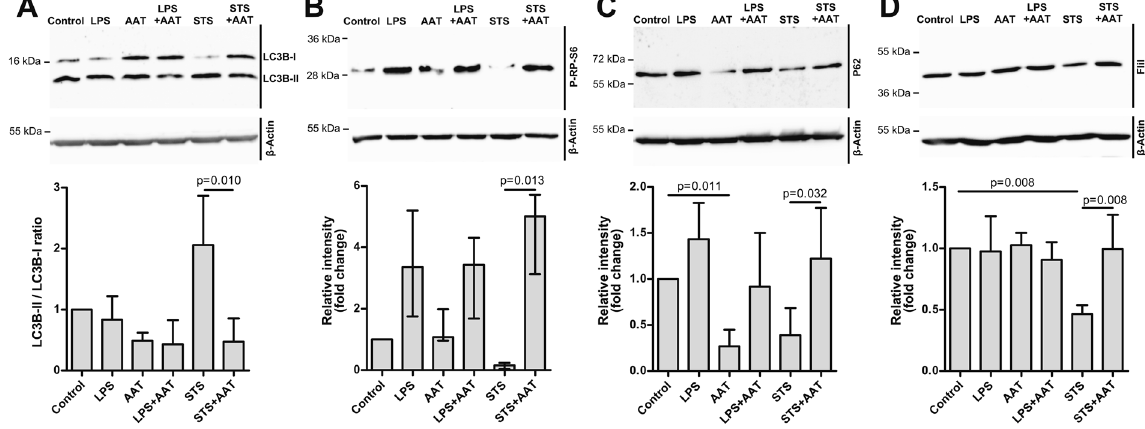
Figure 7. Exogenously added AAT prevents STS-induced inhibition of autophagy. H1975 cells were cultured in medium alone (controls) or in medium containing 50 nM STS, 10 µ g/ml LPS, or 1.5 mg/ml AAT separately and in combination for 2 or 18 h. Cell lysates were analysed by Western blot. ( A ) for LC3B analysis, cell lysates were prepared after 2 h incubation time. LC3B-II versus LC3B-I ratios were calculated. Bars represent mean (SD) of three independent experiments. ( B ) for p-RB-S6 analysis, cell lysates were prepared after 2 h incubation time in lysis buffer containing phosphatase inhibitory cocktail. Bars represent median (25–75 percentiles) of four independent experiments. ( C ) for p62 analysis, cell lysates were prepared after 2 h incubation time. Bars represent mean (SD) of six independent experiments. ( D ) FliI was examined after 18 h of cell incubation. Bars represent mean (SD) of four independent experiments. Fold changes were calculated for each band using the ratio relative to β -actin, as a loading control, and then normalized by the experimental control. Representative blots are shown. p < 0.05 was considered as